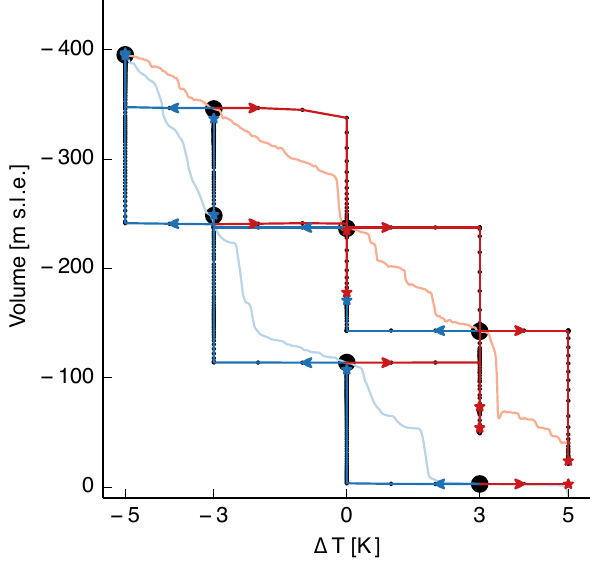
Figure 13. Global ice volume of simulations with a rapid tempera- ture transitions of 1 ◦ C per 1000 years. The base of the transition simulations is the hysteresis simulation from Fig. 11 (b) , which is shown in the background in pale colors. The large black dots are identical to the dots in Fig. 11 and mark the equilibrium state at the specific temperature. Simulations are started from { − 3, 0, +3} ◦ C with temperature increase (red) or decrease (blue) of 1 ◦ C per 1000 years and a runtime of 100000 years (small black dots ev- ery 1000 years) until equilibrium (asterisks). The temperature dif- ference of 3 ◦ C is constantly applied in the first 3000 years and held stable